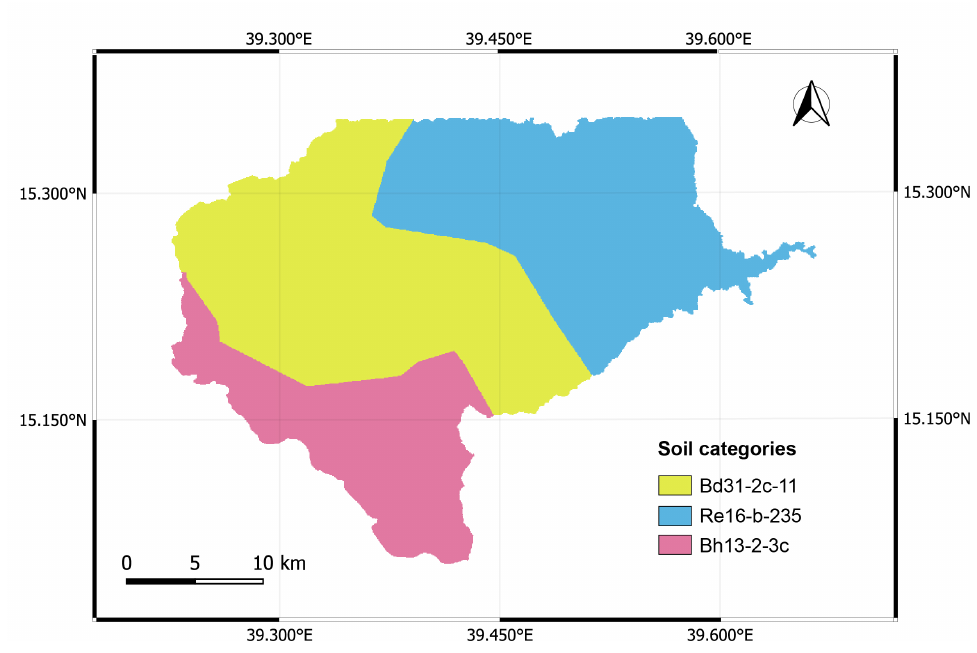
Figure 4. Soil map provided by FAO. The clay, sand, and silt content of each soil group determined by SoilGrids250m [25] data are listed in Table 3. Table 3. Clay, sand, and silt content (%), textural class, and hydrological soil group for the